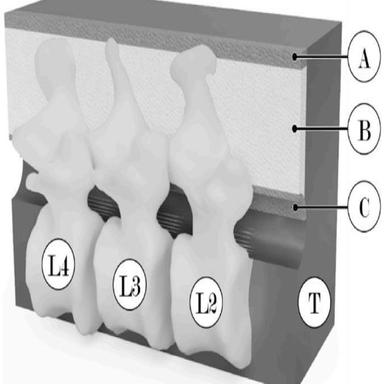
Schematic of a vertebral segment; L2 – L4: lumbar vertebrae; A: lig. supraspinale; B: lig. interspinale; C: lig. flavum; T: connective tissue.